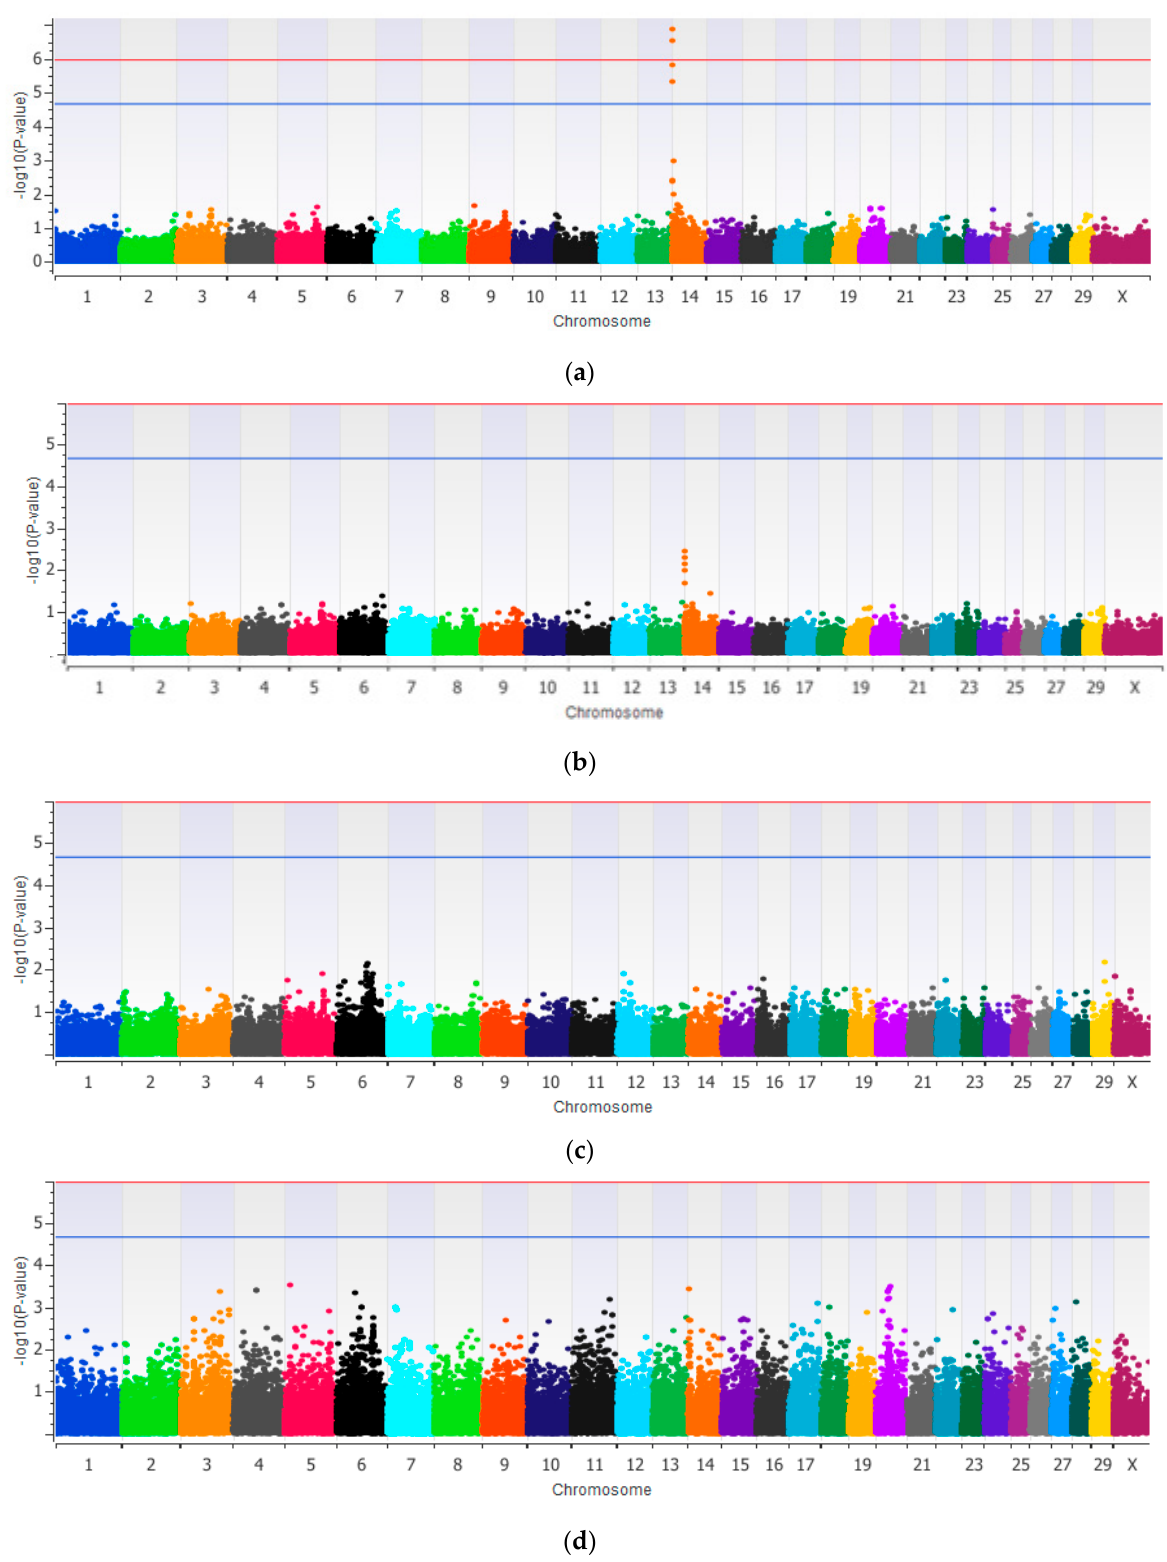
Figure 1. Manhattan plot showing genome-wide associations for fat percentage ( a ), crude protein percentage ( b ), milk urea concentration ( c ) and efficiency of crude protein utilization ( d ). The red line shows the genome-wide significant level at − log 10 ( p -value) = 5.95 and the blue line shows the suggestive association signi fi cant level at − log 10 ( p -value) = 4.65.